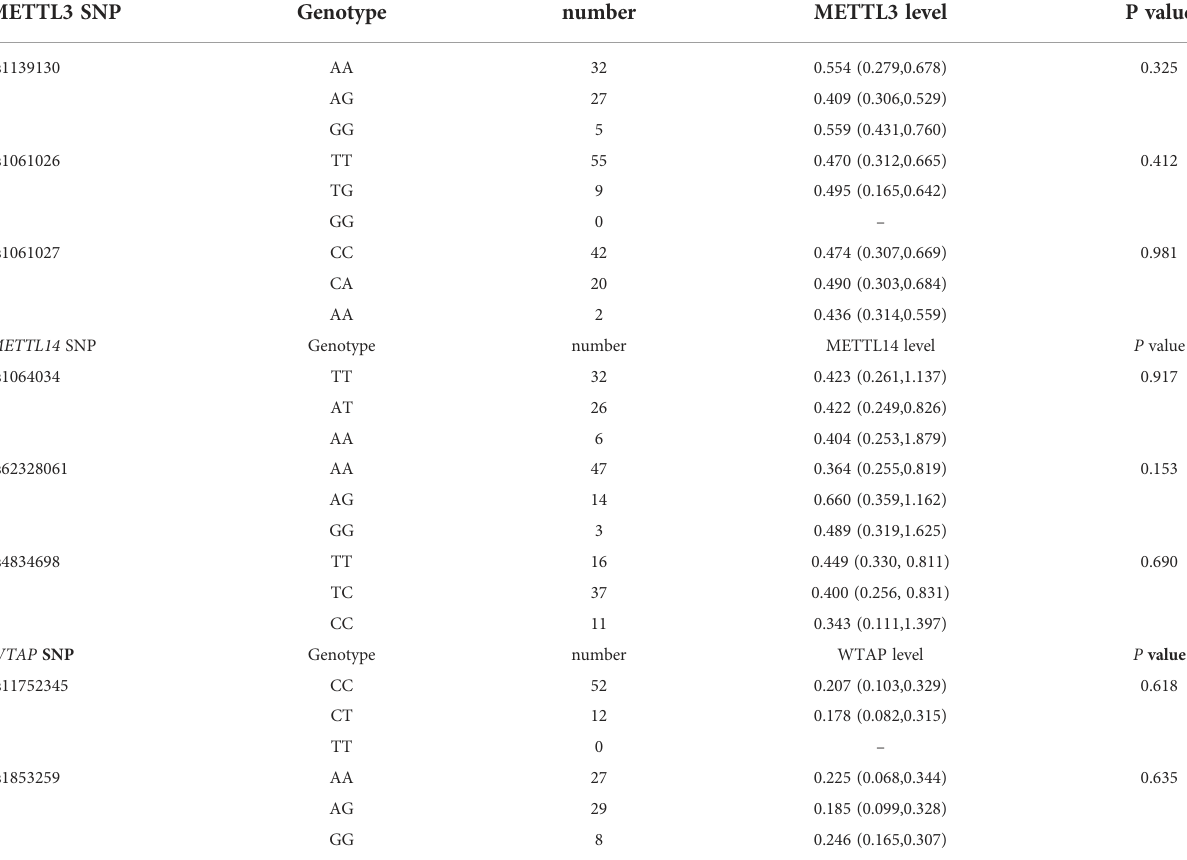
TABLE 6 Association between METTL3 , METTL14 , and WTAP genes polymorphisms with their transcription levels in PTB patients. METTL3 SNP